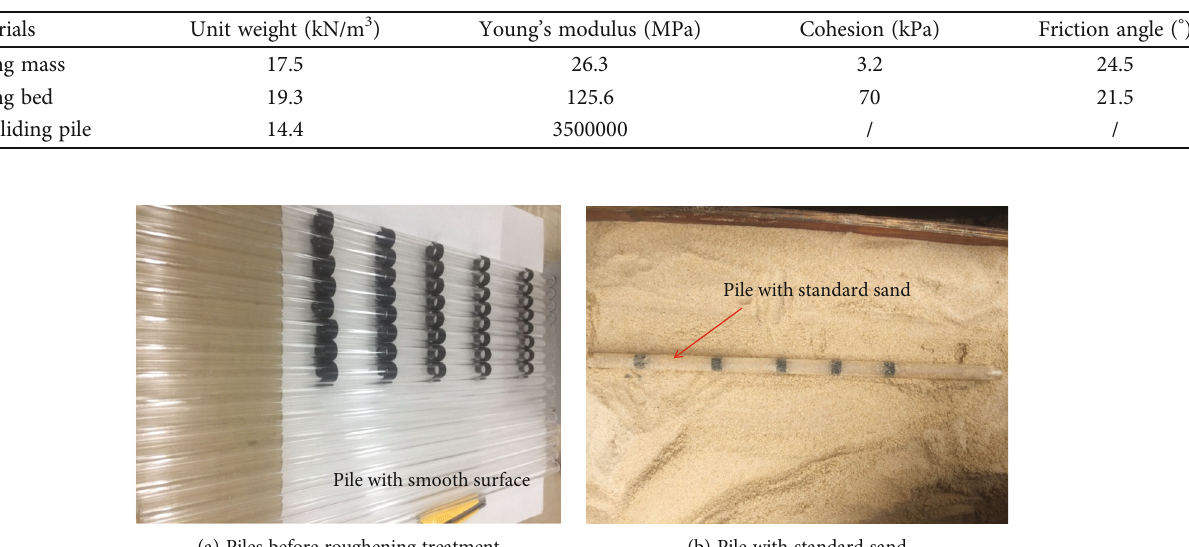
Figure 3: Loading measures for the model Table 1: Material parameters of the model test.